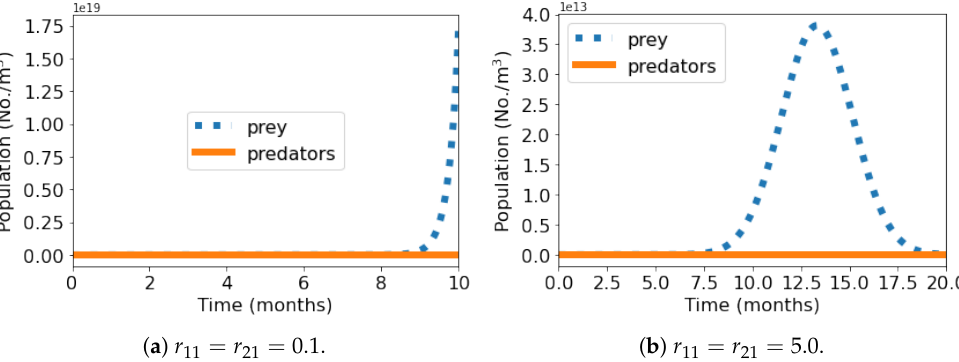
Figure 1. Short-term population dynamics of the predator–prey for α = α (cid:48) = 0. Predator and prey have the same response strength to MP particles, i.e., ∆ = r 11 / r 21 = 1.0. Abscissa measures time in months, and ordinate measures the number of organisms (No./m 3 ). The populations of prey ( x 1 ) and predator ( x 2 ) are represented by the blue dotted line and the orange continuous one,